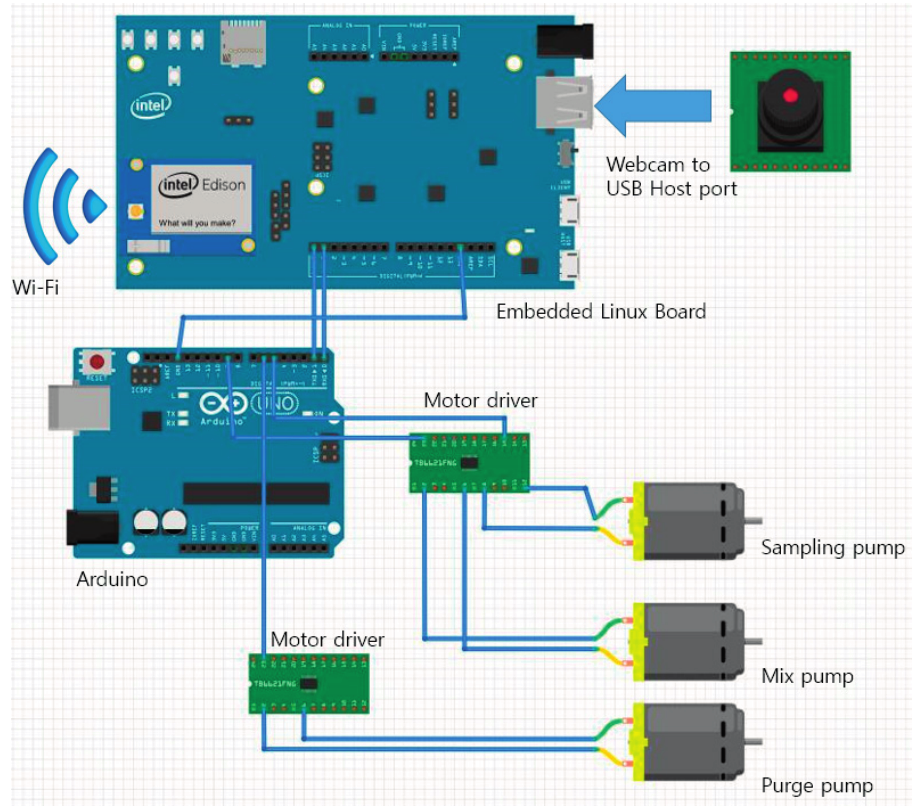
Figure 3. Circuit composition of the system. Power and ground lines are not shown for simplification of the